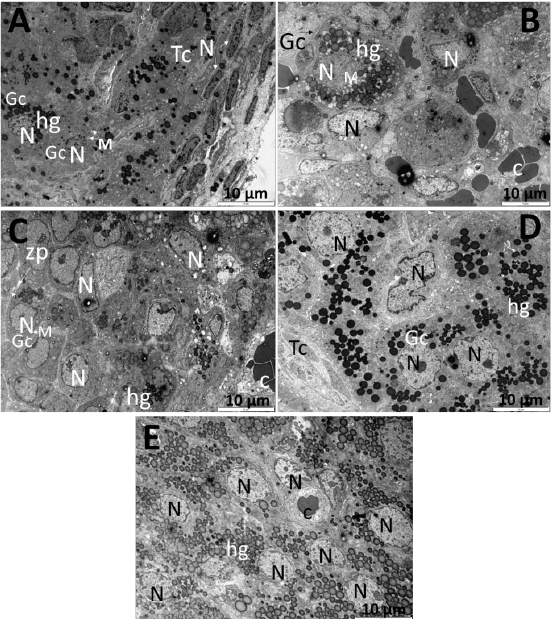
Figure 5. Transmission electron microscopy images (10 μm) of the ovary tissue of Control rats ( A ) and rats exposed to CPA ( B ), CPA + P1 ( C ), CPA + P2 ( D ), and CPA+ P3 ( E ). Image ( A ) indicates normal, undamaged cells (granulosa and theca cells), with clear round-shaped nuclei a with numer- ous high electron dense lipidic granules representing hormone depositions. Panel ( B ) represents the ovary exposed to 200 mg/kg BW CPA, showing several round-shaped oocytes with a smaller num- ber of lipidic granules and significant less electron density. Panel ( C ) reveals a multi-oocyte follicle belonging to CPA + P1 group, having round nuclei and several lipidic granules. Image ( D ) is repre- sentative for CPA + P2 with a remarkable number and higher electron density of the lipidic struc- tures. Image ( E ), from CPA + P3 female rats, shows a multi-oocyte follicle with clear round nuclei and a great number of granules that are not very intense in terms of electron density. N = nucleus, M = mitochondria, hg = hormonal granules/lipidic granules, c = capillary, Tc = theca cells, Gc = gra- nulosa cells, zp = zona pellucida. 4. Discussion It has been demonstrated that chemotherapy alone reduced the ovarian reserve in the growing follicles by activating the apoptosis in the granulosa cells [25 – 28]. Besides, oxidative and nitrosative stress are known to damage cellular macromolecules during fol- licle growth leading to follicular atresia and other damages in the intraovarian microen- vironment, developing the so called premature ovarian insufficiency [29,30]. Granulosa cells are easily affected by ROS, mostly by H 2 O 2 [27]. Therefore, in this paper we provided new insights regarding the oxidative stress effects after cyclophosphamide treatments and P. sempervirens therapy of preserving the ovarian physiological function.